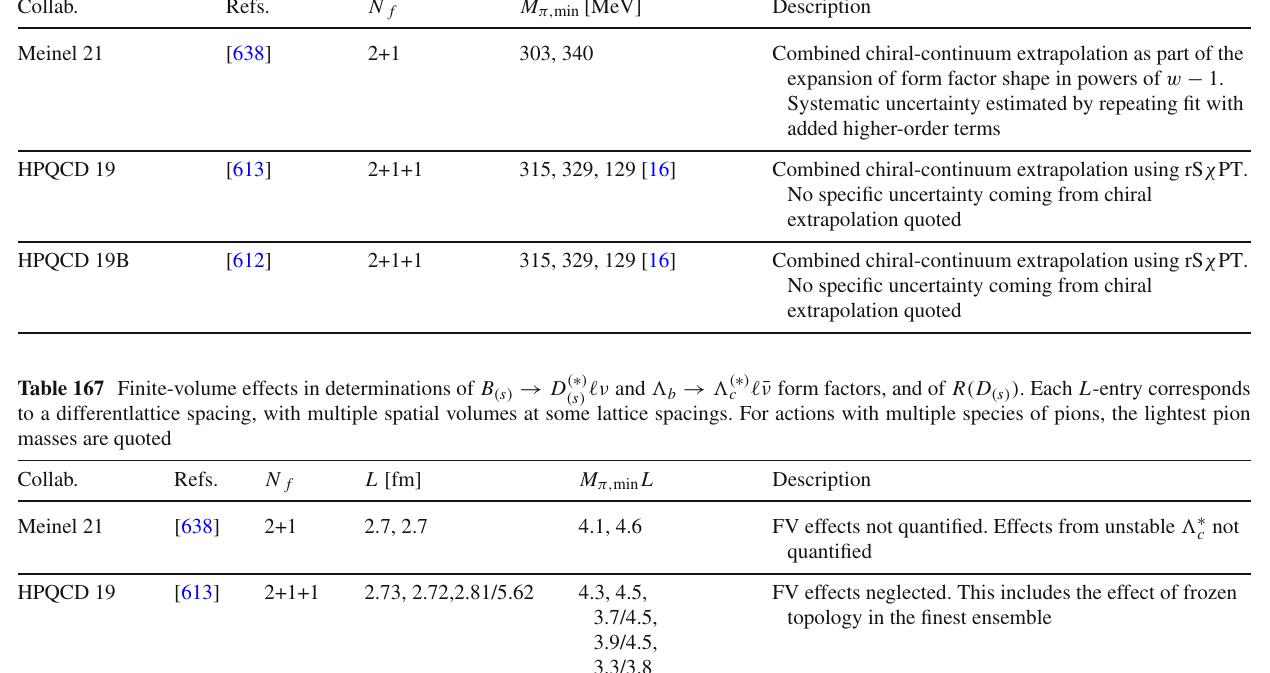
Table 166 Chiral extrapolation/minimum pion mass in N f = 2 + 1 determinations of B ( s ) → D ( ∗ ) ( R ( D ( s ) ) . For actions with multiple species of pions, masses quoted are the RMS pion masses for N f = 2 + 1 and the Goldstone mode mass for N f = 2 + 1 + 1. The different M π, min entries correspond to the different lattice spacings Collab.